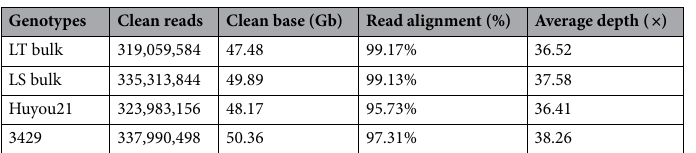
Table 1. Summary of the sequencing results for the parental lines and two bulks.